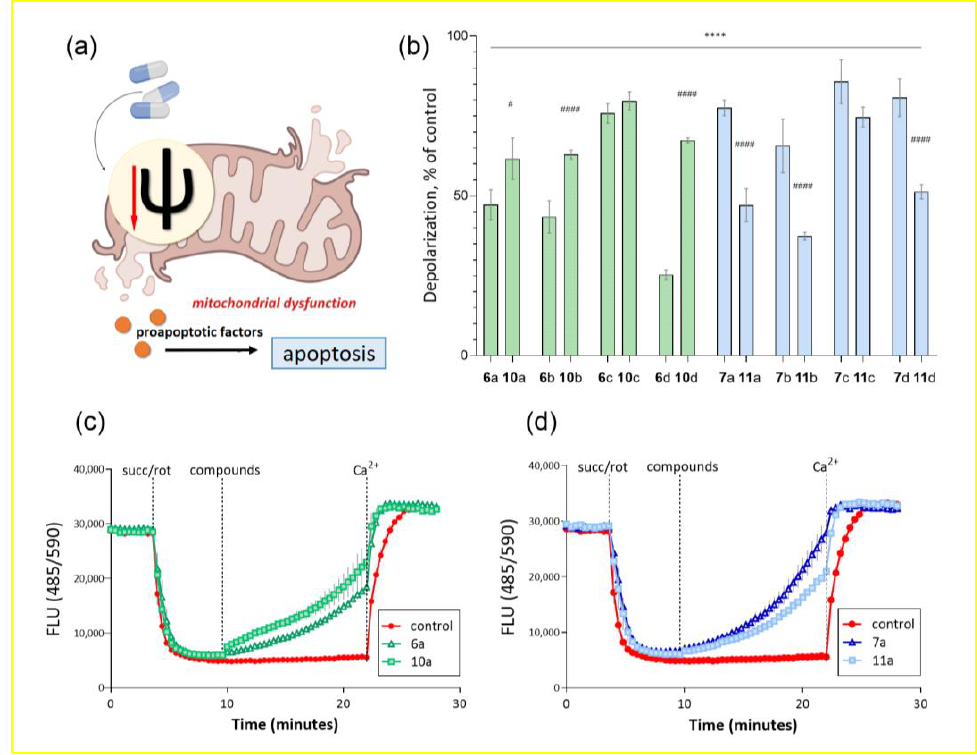
Figure 2. Effect of conjugates of dehydrocostuslactone and alantolactone with alkoxy-substituted benzyl azides on the transmembrane potential of isolated rat liver mitochondria. ( a ) Schematic representation of the effect of mitochondrial membrane depolarization on triggering cell death via the mitochondrial-dependent apoptosis pathway. ( b ) Percentage of mitochondrial membrane depolarization at a given time interval relative to control (as mean ± SEM ( n = 3)). **** p ≤ 0.0001 compared to control, # p ≤ 0.05 and #### p ≤ 0.0001 compared to corresponding long spacer conjugate (one-way ANOVA). Kinetic curves of changes in the transmembrane potential of mitochondria under the action of conjugates ( c )—dehydrocostuslactone 6a and 10a and ( d )—alantolactone 7a and 11a with aromatic alkoxy derivatives. The concentration of the studied compounds was 100 µ M, potassium succinate, 5 µ M, rotenone, 0.5 µ M, Ca 2+ , 25 µ M. ∆Ψ m was estimated from fluorescence quenching of the lipophilic cationic dye